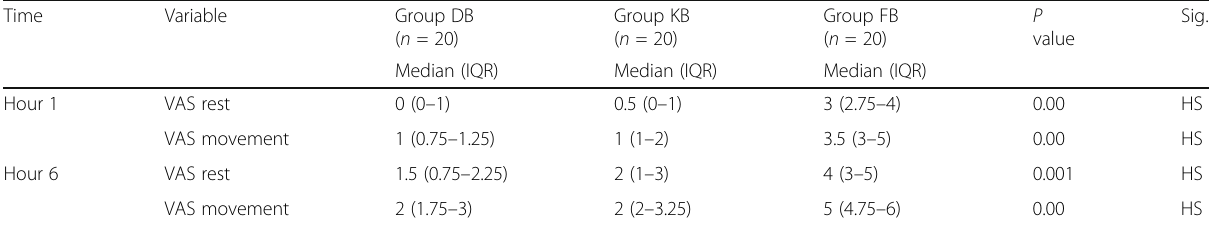
Table 4 VAS at 1 h and 6 h